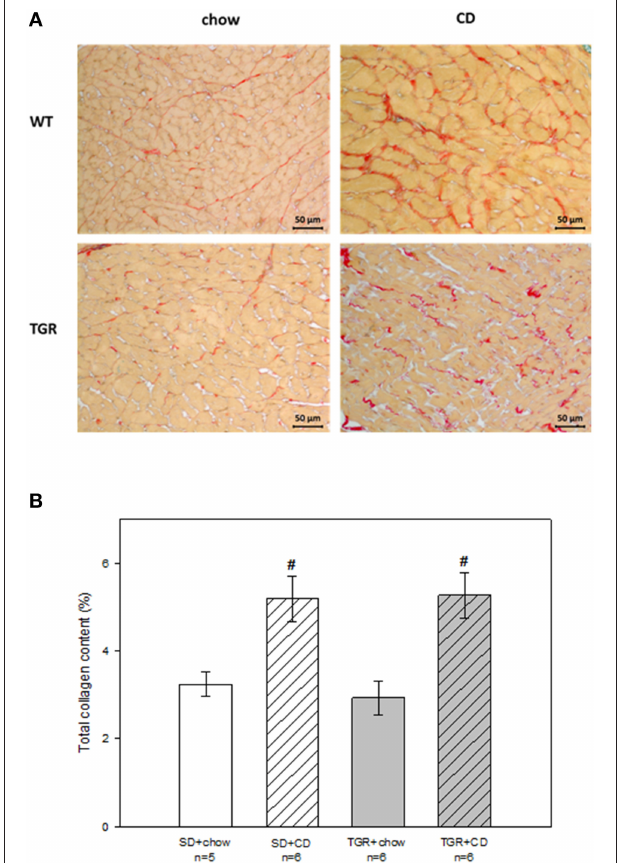
FIGURE 4 | Total collagen content in the myocardium of male wild type Sprague Dawley rats (SD) and transgenic rats (TGR), overexpressing Ang(1-7) after a 5 month feeding period with either standard chow alone or simultaneously chow and cafeteria diet (CD). (A) Original histological images of 2 µ m sections of rat myocardium stained with Picrosirius Red. (B) Quantitative analysis of total collagen content. CD caused myocardial fibrosis in both WT and transgenic rats, without differences between these groups. Data are expressed as means ± SEM of n experiments. Significant changes vs. chow rats are indicated by a hash key ( p < 0.05 ). Total collagen content was analyzed by ANOVA followed by pairwise comparison using Tukey